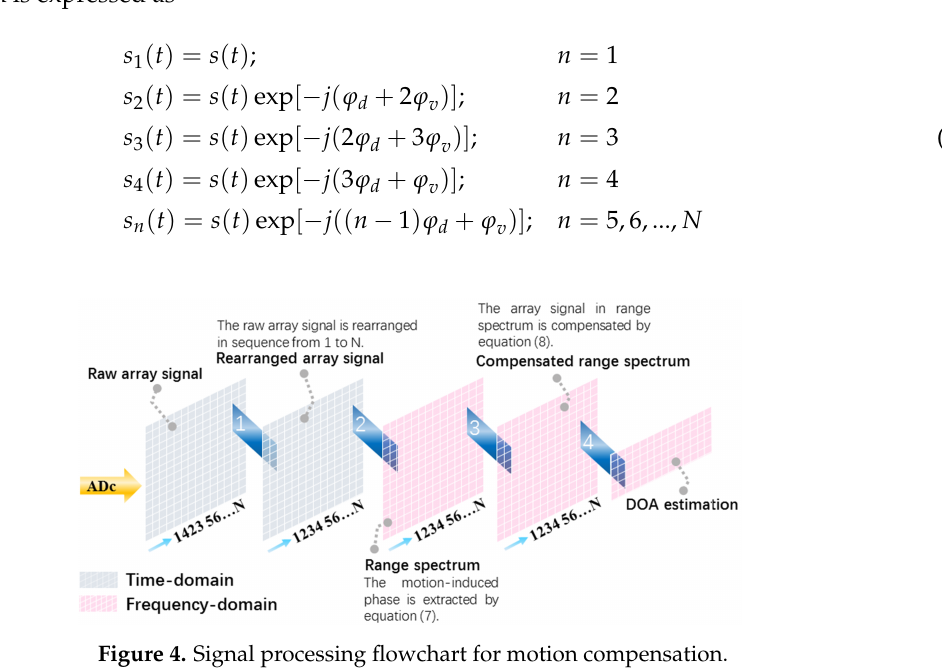
Figure 4. Signal processing flowchart for motion